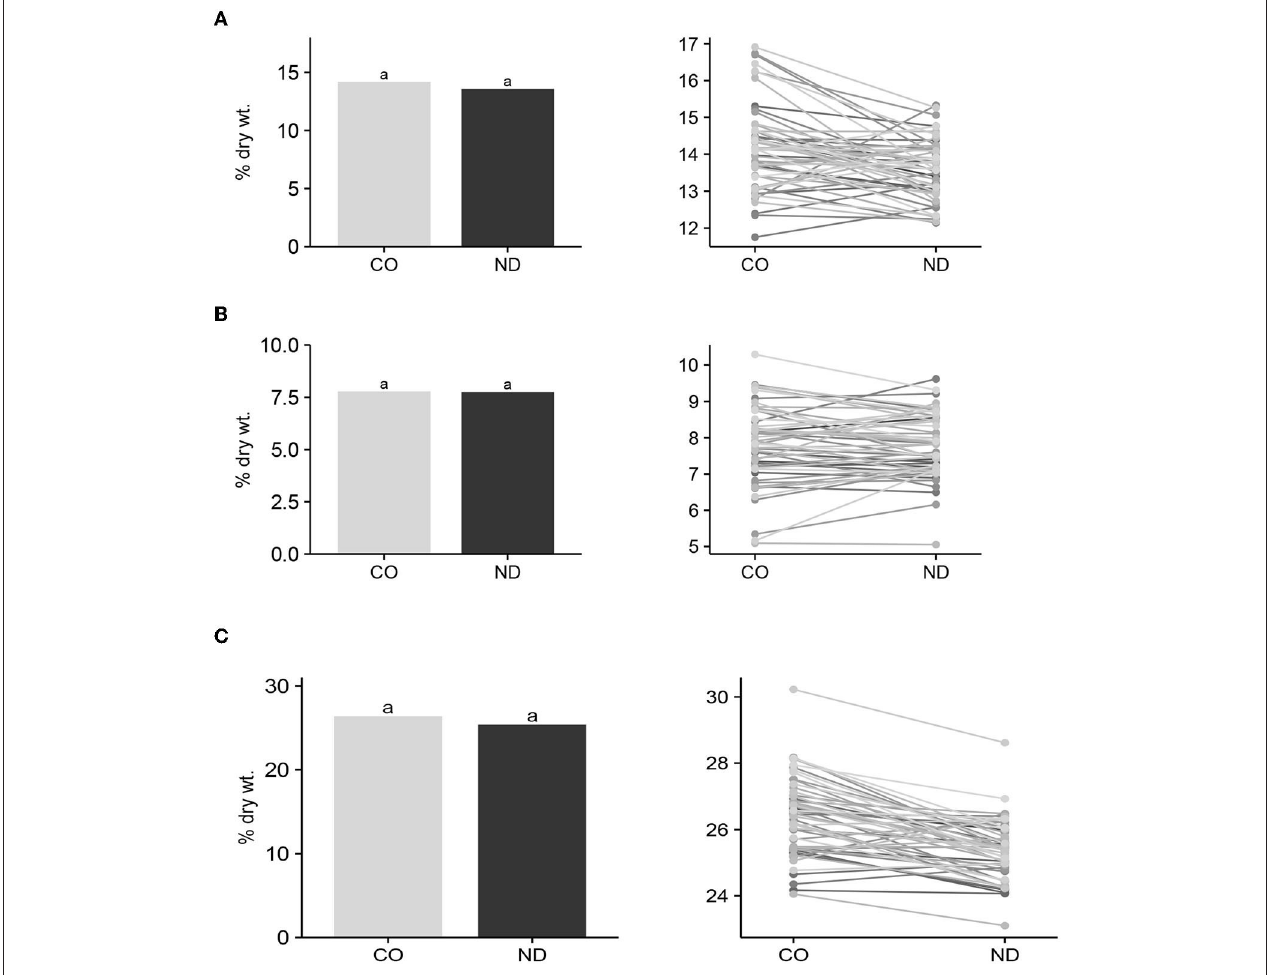
FIGURE 1 | Mean insoluble (A) , soluble (B) and total dietary fiber (C) content among cultivars/lines ( n = 57) grown in Colorado (CO) and North Dakota (ND), and graphic response of content among entries over locations. Bar means with the same lowercase letter are not significantly ( P ≤ 0.05) different between